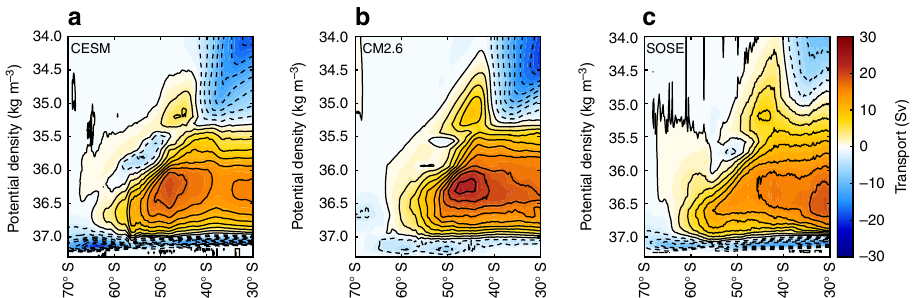
Fig. 3 Model comparison of Southern Ocean zonally averaged circulation. Meridional overturning streamfunction (Sverdrups) in a CESM, b CM2.6, and c SOSE. Solid and dashed contours represent positive and negative transport, respectively, with an interval of 2.5